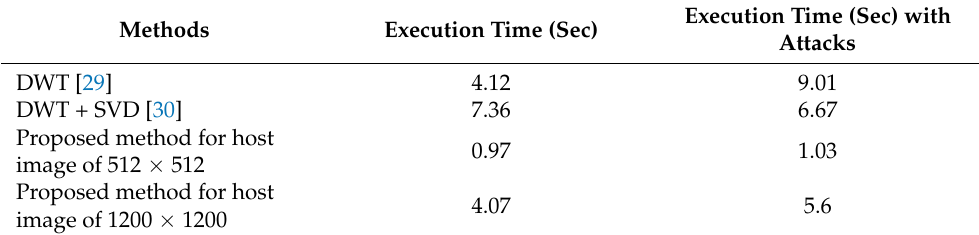
Table 6. Execution time